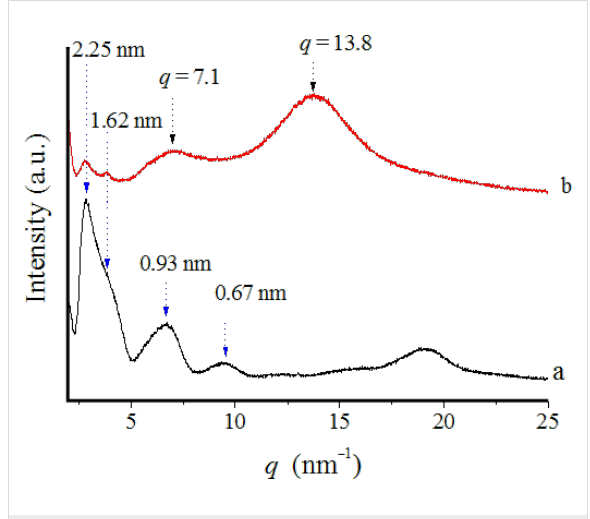
Figure 7: WAXD profiles of (a) original imogolite and (b) DDPO 4 - imogolite. Adapted with permission from W. Ma et al., Chem. Lett. 2011, 40, 159–161 [33]. © 2011, The Chemical Society of